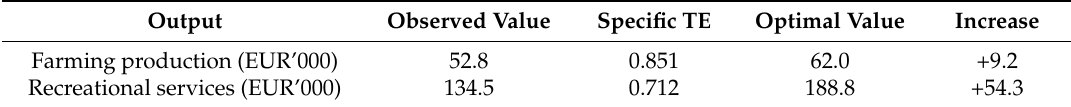
Table 4. Optimal (fully efficient) outputs estimated by